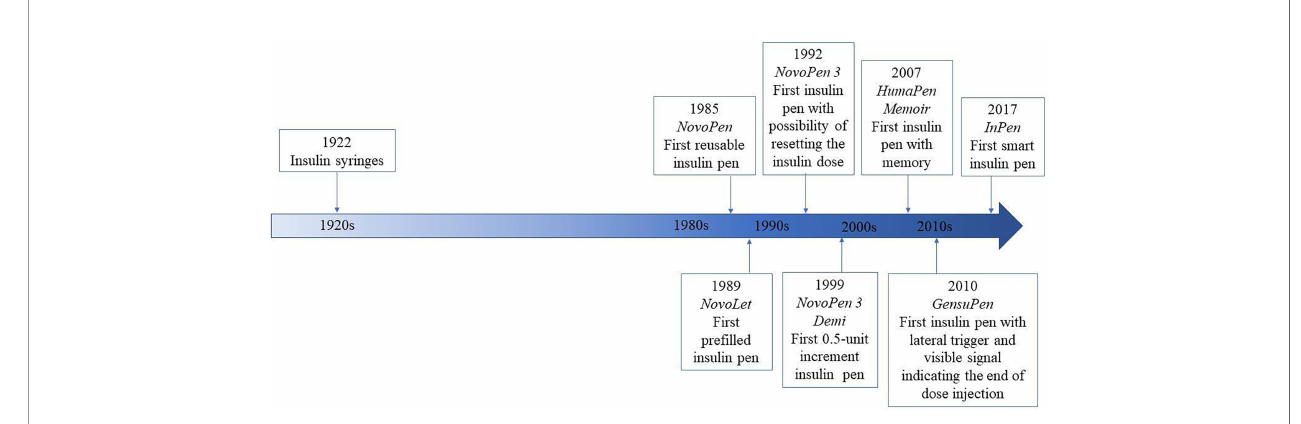
FIGURE 1 | Timeline of insulin pen history.